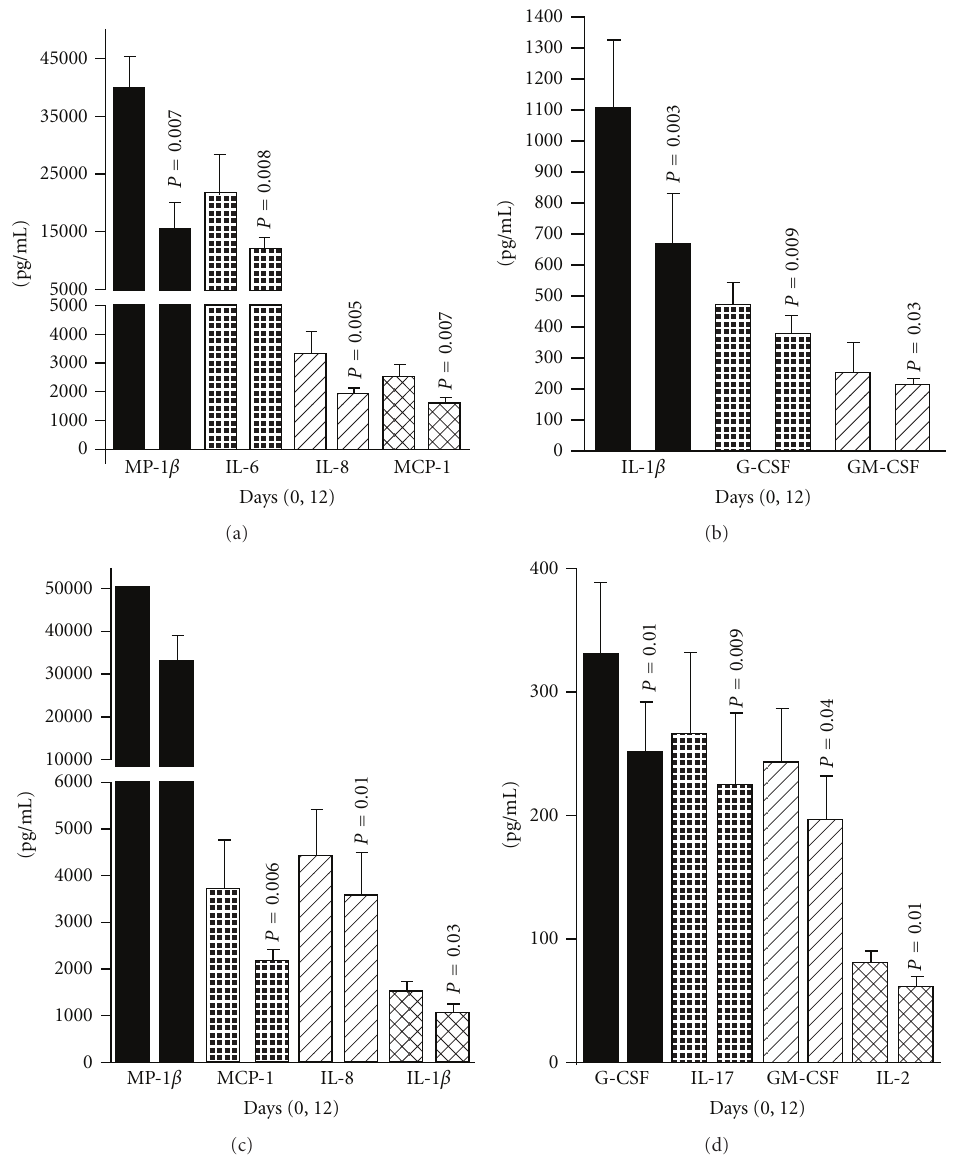
Figure 4: Bar graphs (mean and standard error the mean (SEM)) with levels of cytokines (pg/mL) MIP-1 β , IL-6, IL-8, and MCP-1 (a) and IL-1 β , G-CSF, and GM-CSF (b) in stimulated (LPS 1 ng/mL ) whole blood ex vivo from eleven patients (unless otherwise stated) with ulcerative colitis prior to (day 0) and after AndoSan consumption for 12 days. Days 0 and 12 after stimulation are depicted by the first and second bars from the left, respectively. For MIP-1 β and IL-8, measurements in nine out of ten patients were available. Corresponding measurements from eleven patients with Crohn’s disease (unless otherwise stated) were significantly reduced for cytokines MIP-1 β , MCP-1, IL-8, and IL-1 β (c) and G-CSF, IL-17, GM-CSF, and IL-2 (d). For MIP-1 β and IL-8, measurements in ten out of eleven patients were available. Despite remeasurement of MIP-1 β after dilution of plasma 1/10, high out of range values still occurred. Accordingly, the true concentrations of MIP-1 β were even higher. The P values between the bar graphs compare with the cytokine levels at day 0 prior to the intake of AndoSan. From [24] where the data was part of scatter plots in Scand J